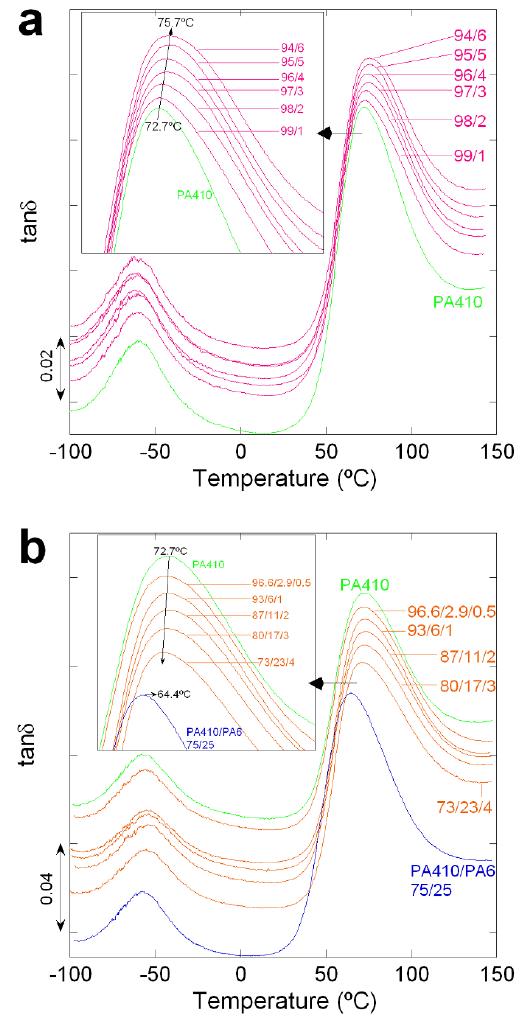
Figure 5. DMTA curves of ( a ) neat PA410 and PA410/CNT NCs and ( b ) neat PA410, the 75/25